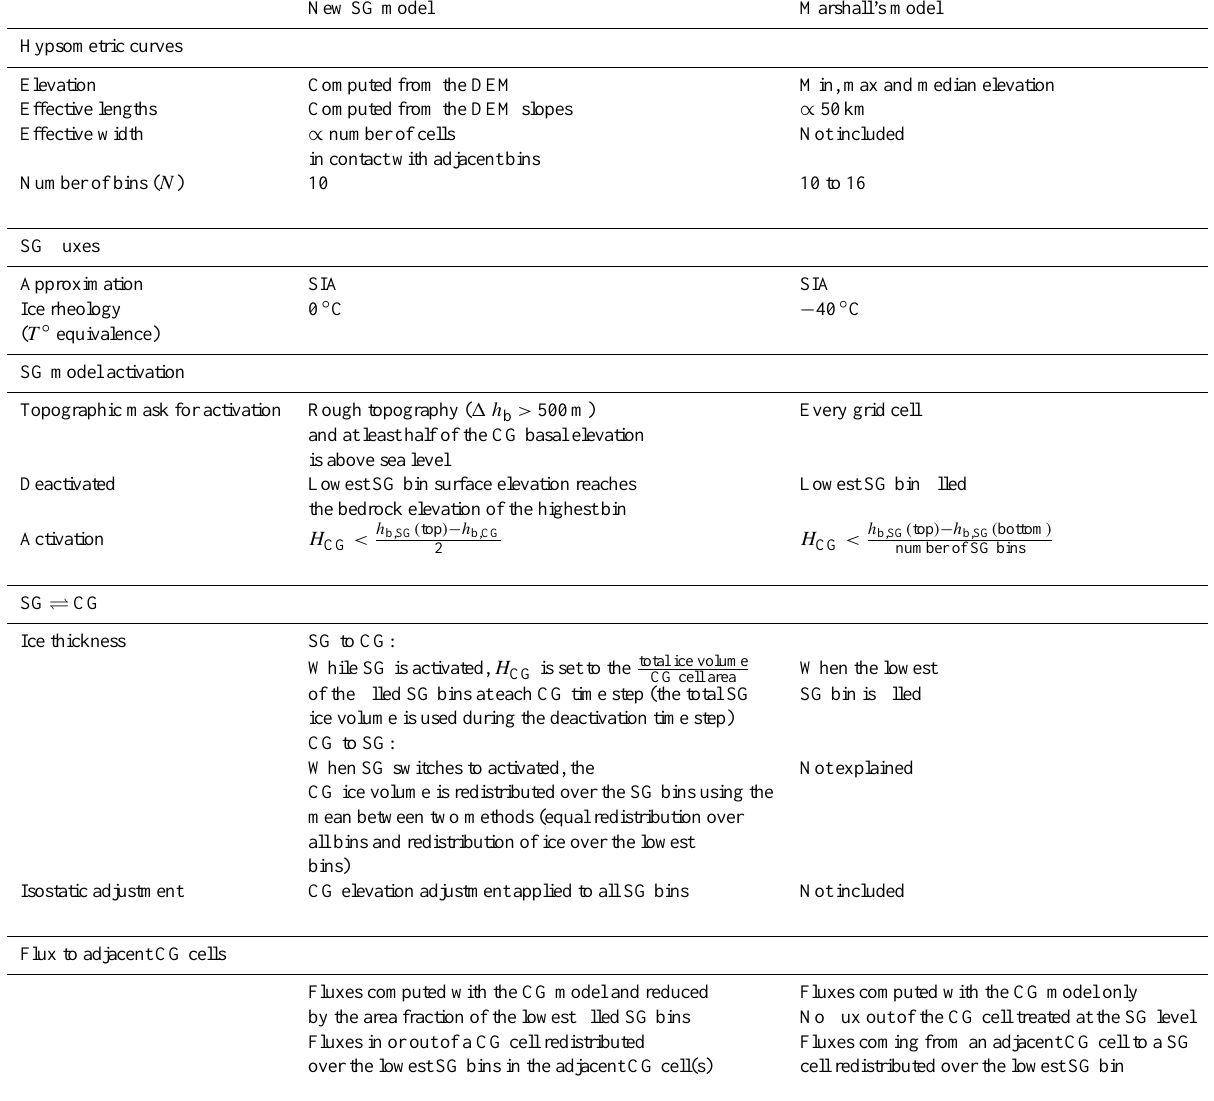
Table 1. Differences between our new SG model and the Marshall and Clarke (1999)/Marshall et al. (2011)